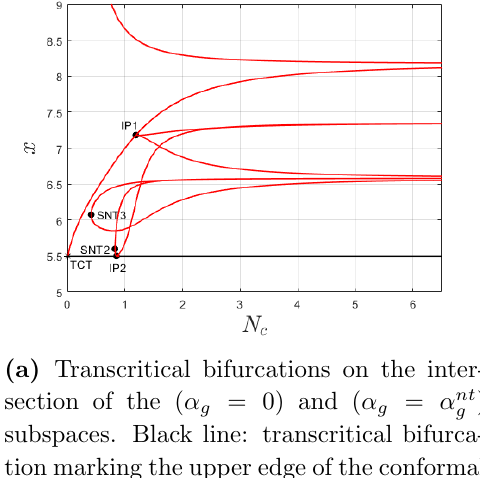
Figure 4. Bifurcations of the QCD 4 model (2.7), shown in the ( N c ; x )-plane. Red Lines: trans- critical bifurcations. Blue lines: saddle-node bifurcations. Dashed lines: bifurcation curves, with at least one of the coupling constants g i > 1. CP: Cusp bifurcation. SNT: j j